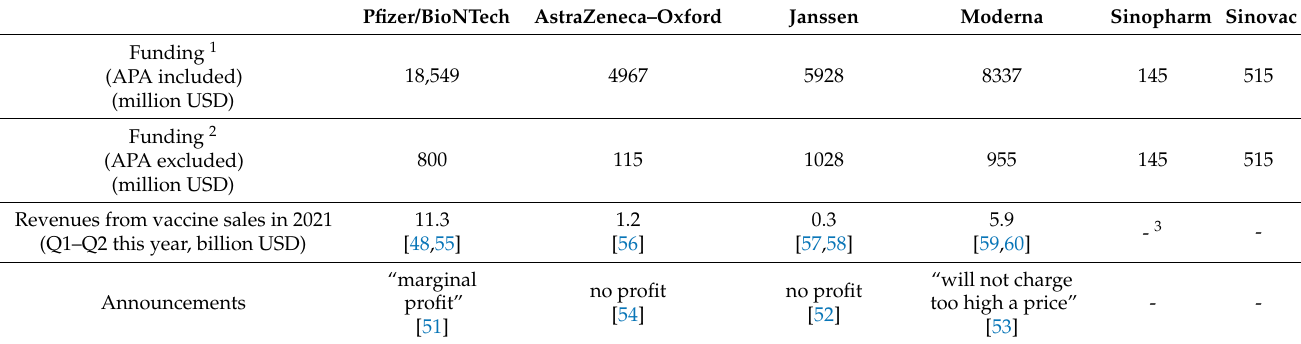
Table 2. Funding, revenues, and stance on the profit generation of EUL COVID-19 vaccines. Pfizer/BioNTech